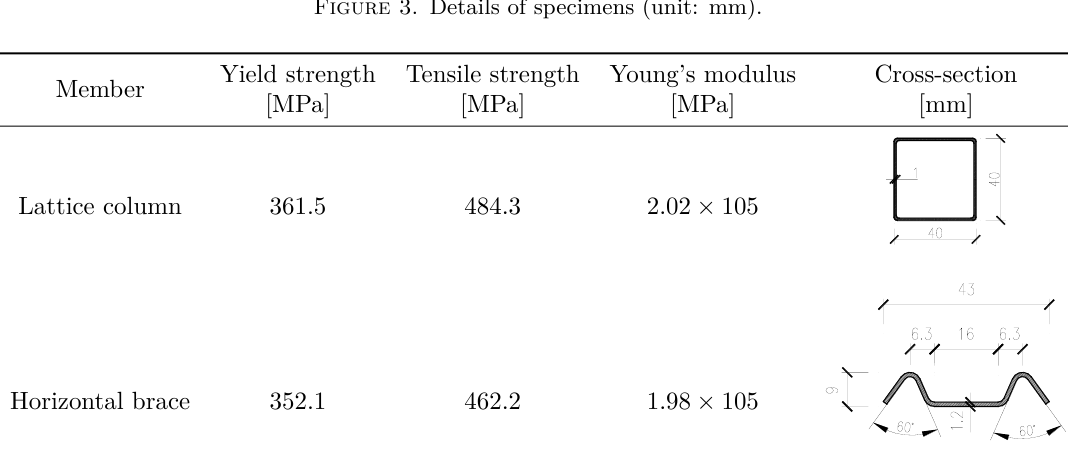
Figure 3. Details of specimens (unit: mm).